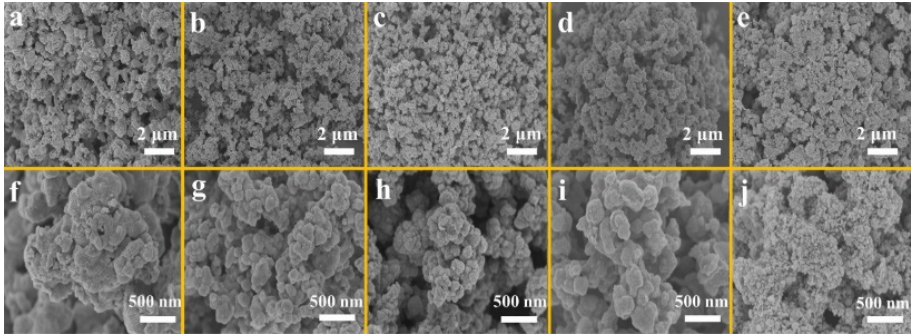
Figure 7. SEM images of ( a , f ) Co 3 O 4 , ( b , g ) Co 3 O 4 /CeO 2 , ( c , h ) 3Co 3 O 4 /CeO 2 (Co 3 O 4 /CeO 2 having the molar ratio of Co/Ce = 3:1), ( d , i ) 5Co 3 O 4 /CeO 2 (Co 3 O 4 /CeO 2 having the molar ratio of Co/Ce = 5:1), and ( e , j ) 7Co 3 O 4 /CeO 2 (Co 3 O 4 /CeO 2 having the molar ratio of Co/Ce = 7:1). Reproduced with permission from Ying Kang, Highly efficient Co 3 O 4 /CeO 2 heterostructure as anode for lithium-ion batteries; published by Elsevier, 2020 [11].